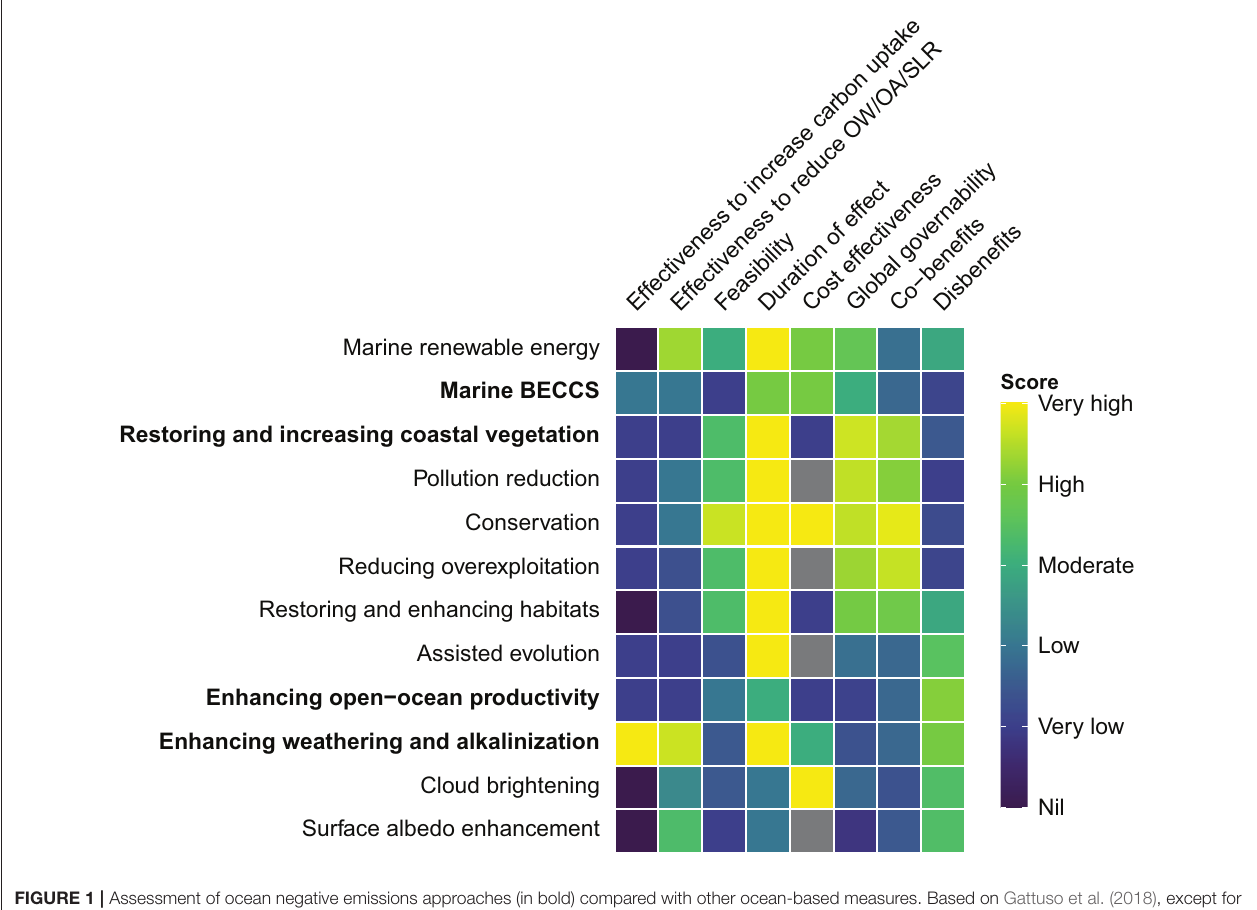
Frontiers in Climate |